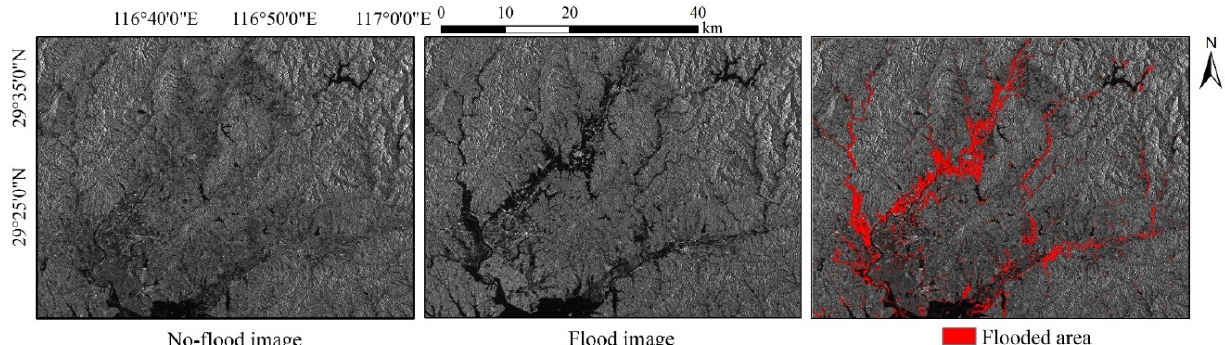
Figure A3. Flood detected in Shengjin Lake in 2020.